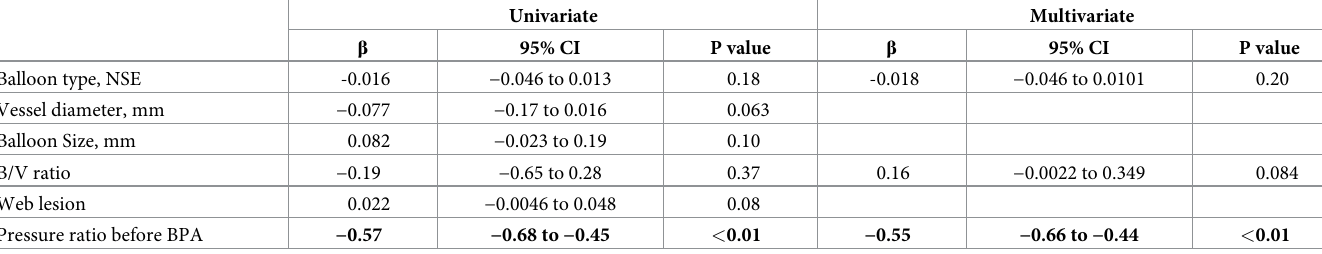
Table 4. Univariate and multivariate analysis of Δ Pressure ratio. Univariate Multivariate β 95% CI P value β 95% CI P